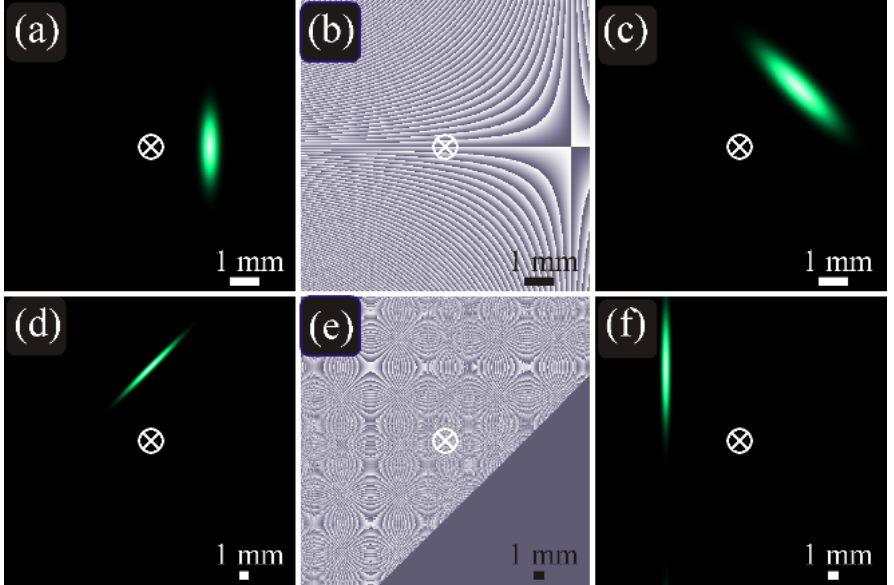
Figure 3. Intensity ( a , c , d , f ) and phase ( b , e ) distributions of the propagation-invariant off-axis elliptic Gaussian beam (22) in the initial plane ( a , b , d , e ) and at the Rayleigh distance z = z 0 ( c , f ) for the following parameters: wavelength λ = 532 nm, Gaussian beam waist radii σ x = 1425 μ m and σ y = 365 μ m ( w 0 = 500 μ m) ( a – c ) and σ x = 4583 μ m and σ y = 355 μ m ( w 0 = 500 μ m) ( d – f ), coordinates of the beam center ( x 0 , y 0 ) = (2, 0) mm ( a – c ) and ( x 0 , y 0 ) = (0, 7.5) mm ( d – f ), tilt angle of the major ellipse axis to the x -axis α = π /2 ( a – c ) and α = π /4 ( d – f ), computation domain | x |, | y | ≤ R with R = 5 mm ( a – c ) and R = 15 mm ( d – f ). The cross in the center shows the optical axis, around which the diffraction pattern rotates on propagation. Distributions in the initial plane are obtained by Equation (22), whereas at the Rayleigh distance they are computed numerically with the Fresnel transform and, for comparison, also by Equation (22) (the differences are visually undistinguishable). The triangular area of homogeneous phase ( e ) is the area of ultralow intensity, which is treated by the computation software as the exact